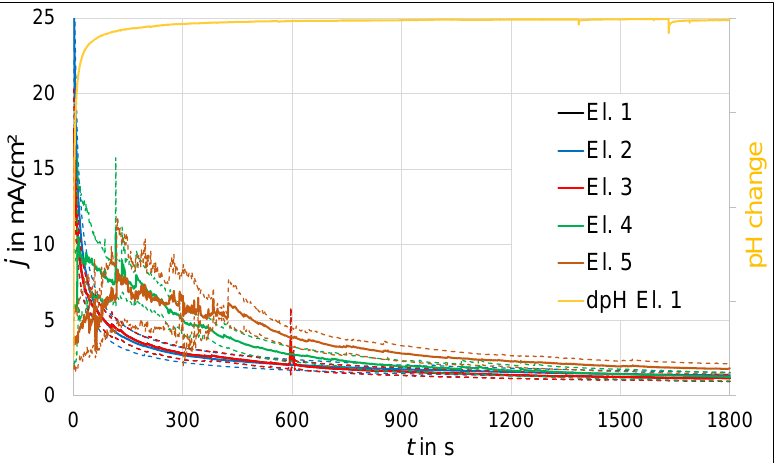
Figure 4. j – t curves due to polarization at constant potential (OCP + 4 V) in the different electrolytes and qualitative pH change (dpH) during a measurement in electrolyte 1. The dashed lines represent the standard deviation between the repetition samples.